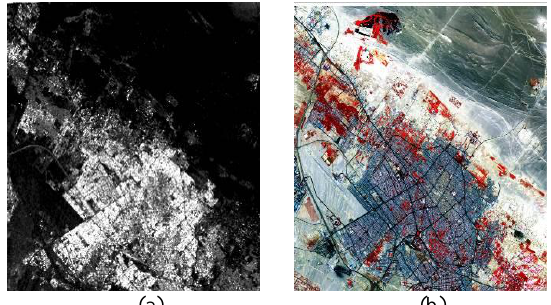
Figure 4. Percentage linear enhancement of 5% in the